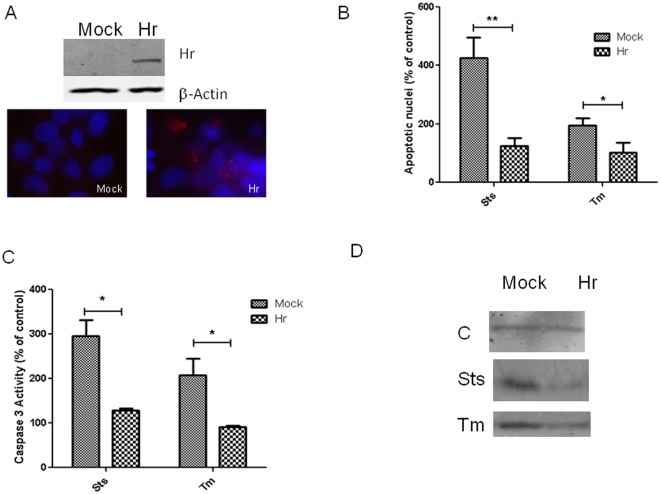
High levels of Hr expression attenuate apoptosis in COS cells.Hr was examined by Western blotting and immunocytochemistry at 48 hours after COS cells were transfected with the RK5 (mock) or RK5Hr (Hr) expression vector (A). At 24 hrs after apoptosis was induced with staurosporine (sts, 100 µM) and tunicamycin (tm 1 µg/mL), the number of cells displaying fragmented nuclei was counted after staining with DAPI (B). Caspase-3 activity was determined by measuring the release of pNA colorimetrically with the substrate Ac-DEVD-pNA (C). The percent control is computed by dividing the value from cultures treated with inducer by the value in cultures without (control) multiplied by 100. Data are expressed as means of triplicate cultures (± S.E.M.) and were repeated in three independent experiments. * indicates p<0.05 and ** indicates p<0.01 as determined with ANOVA and Tukey's post hoc test. To determine cytochrome C release, cytosolic fraction were subjected to Western blotting and probed with a rabbit antibody against cytochrome C and subsequent goat anti rabbit antibody with an infrared probe (D). Western blots were visualized with the Odyssey.